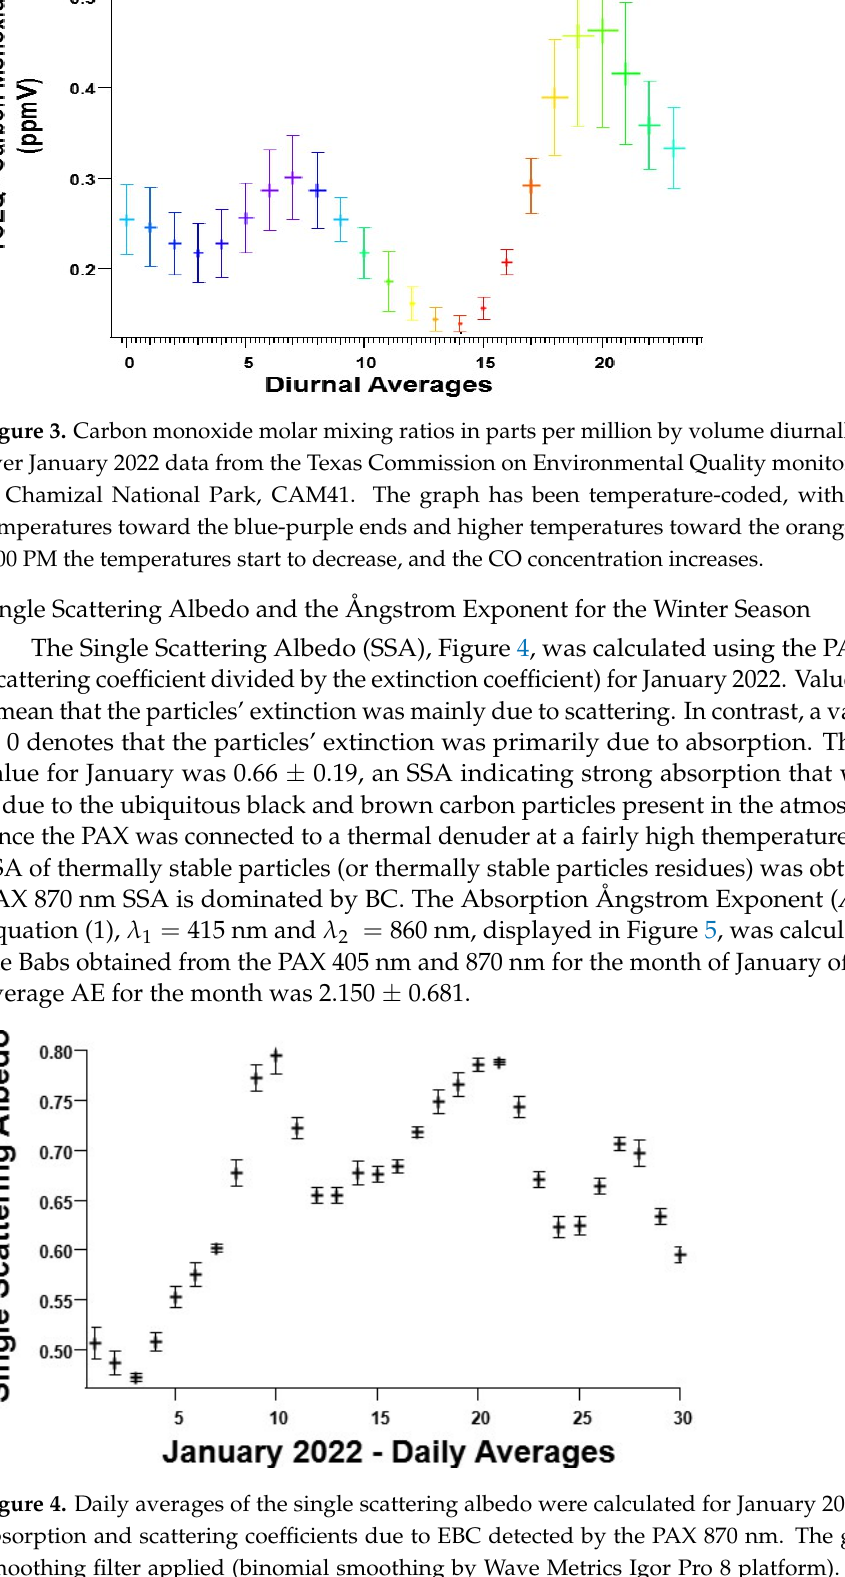
Figure 5. The absorption Ångstrom Exponent—Equation (1)—was calculated using the Babs calcu- lated at 405 nm and 870 nm with the data obtained by the PAX instruments. The values represent daily averages for the month of January 2022. A binomial smoothing was applied (IGOR Pro 8) to show the shape of the data. 3.2. EBC and BrC Summer Wildfire Seasonal Characterization One of the primary objectives of our study was to identify BC and BrC particles emit- ted by wildfires. The first step was to establish the baseline (as defined in Section 2.3.2) of the Babs for the period. Figure 6 shows these baselines as measured by both instruments. Here, we still see the two main peaks, where the third peak in the early morning hours is almost non-existent (compared to Figure 2a for example), which are driven by the heavy traffic at peak hours. The Summer baseline Babs had similar sources to the Winter season in Section 3.1. We observed non-periodical but obvious increments to the baseline during the summer season and conclude that such increments were due to wildfire smoke. We used two different models to show that the US West Coast wildfire plumes reached the El Paso—Ciudad Juarez airshed. One of these models is the High-Resolution Rapid Refresh (HRRR). The HRRR model maps showed that the west coast wildfire plumes usually travel in a North-East direction, later moving southward into our region.